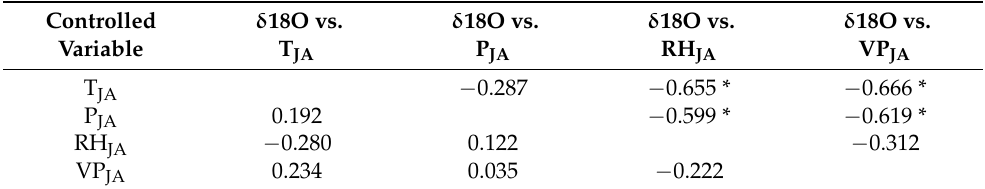
Table 1. Analysis of partial correlation between the tree ring δ 18 O chronology and climatic records from July to August